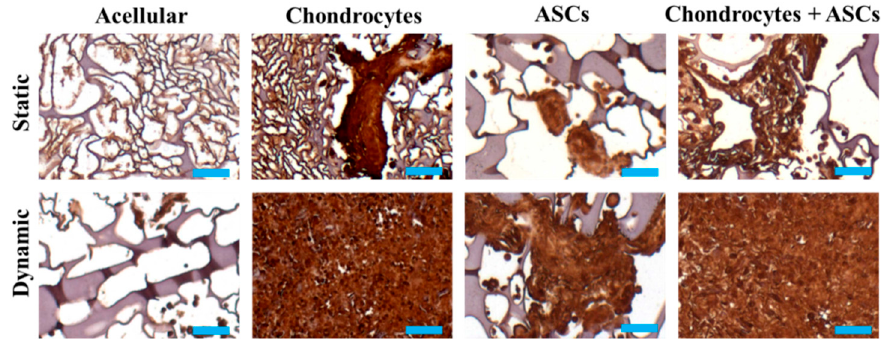
Figure 8. Immunohistochemical staining of Col II of implants eight weeks after subcutaneous implantation in nude mice. The cells/scaffold constructs were cultured in cryogel scaffolds for 14 days under static or cyclic compressive loading (frequency = 1 Hz, strain = 20% and duration = 3 h/day) conditions before implantation. Scale bar = 50 µm.